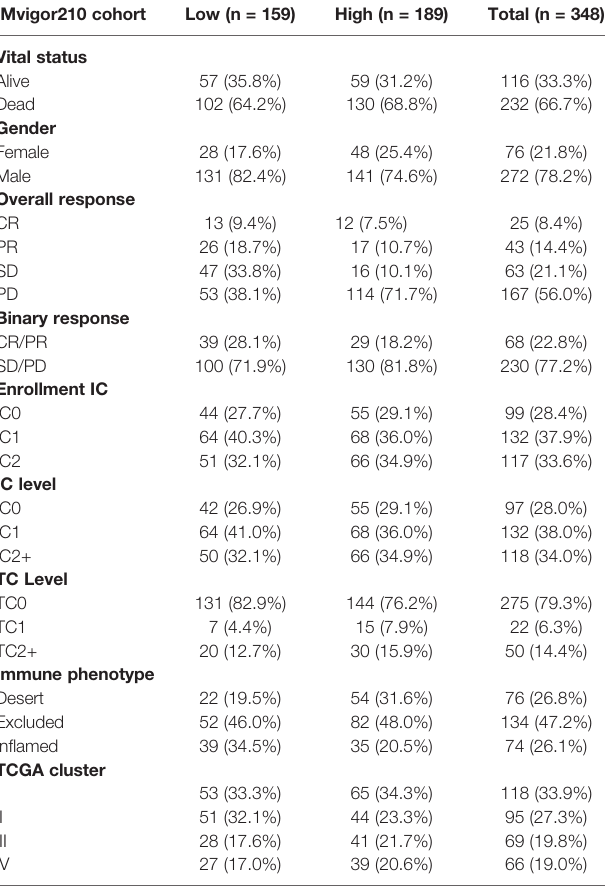
TABLE 2 | Clinical characteristics of the bladder cancer patients in IMvigor210 (mUC) cohort used in this study. IMvigor210